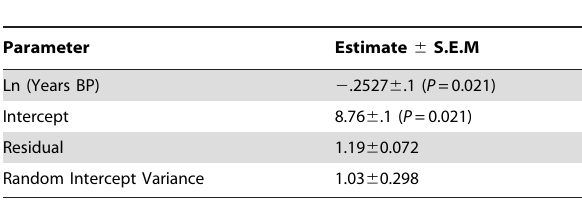
Table 3. Estimates of fixed effects and covariance parameters for the linear mixed model describing the correlation between rates of cultural change as a function of their age, expressed in years